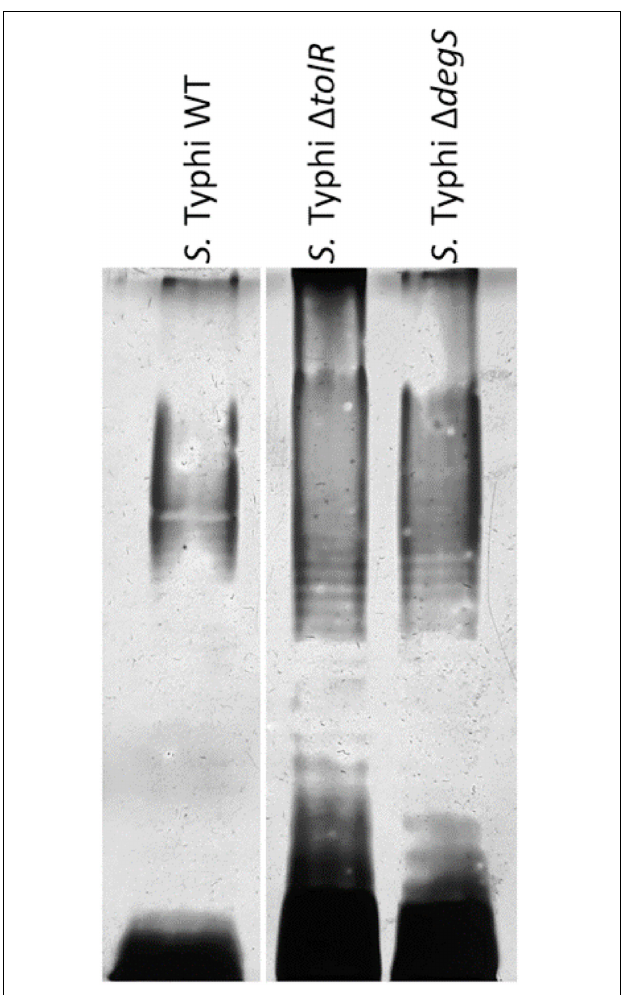
FIGURE 7 | LPS of OMVs extracted from S. Typhi WT, (cid:49) tolR , and (cid:49) degS . OMVs were extracted as described, and the LPS profile was resolved as described in section “Materials and Methods.” In each lane, 40 µ g/mL (proteins) of OMVs were